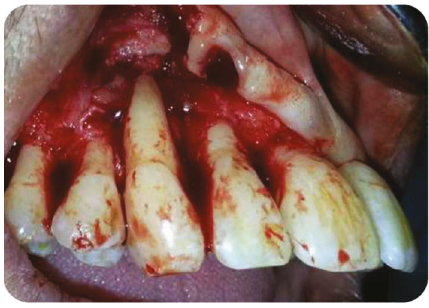
Figure 8: Open fl ap of upper right quadrant.